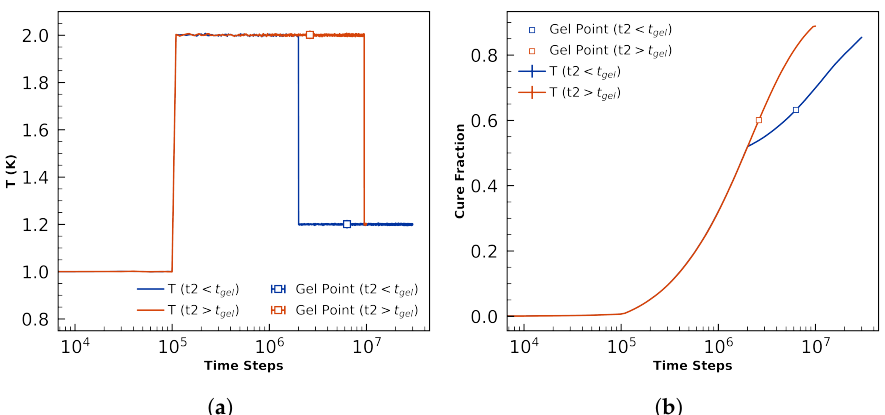
Figure 10. Temperatures profiles ( a ) and curing profiles ( b ) for t 2 < t gel ( t 2 = 2 × 10 6 ∆ t ) and t 2 > t gel ( t 2 = 9.5 × 10 6 ∆ t ). The hollow squares show gel point. T2 is chosen to be higher than and T3 is chosen to be slightly lower than the T g of the fully cured system ( T g ( α = 1.0 ) = 480 K